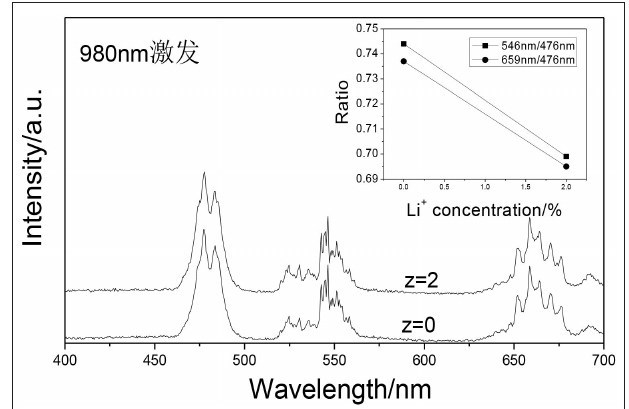
FIGURE 10 | UCPL spectra of the GdAlO 3 :0.6%Er 3 + , 16%Yb 3 + , 1%Tm 3 + ,